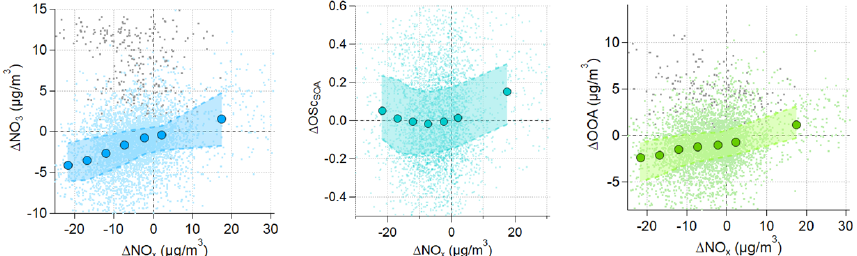
Figure 8. Same as Fig. 7a, for NO 3 , OOA and OSc SOA . Grey dots correspond to days with predominant long-range transport, identified by a positive NO 3 and OOA concentration change concomitantly with a SO 4 concentration peak (Fig. 9), which have been excluded from percentile calculations. Markers represent the median, bottom and top and the shaded area the 25th and 75th percentile,